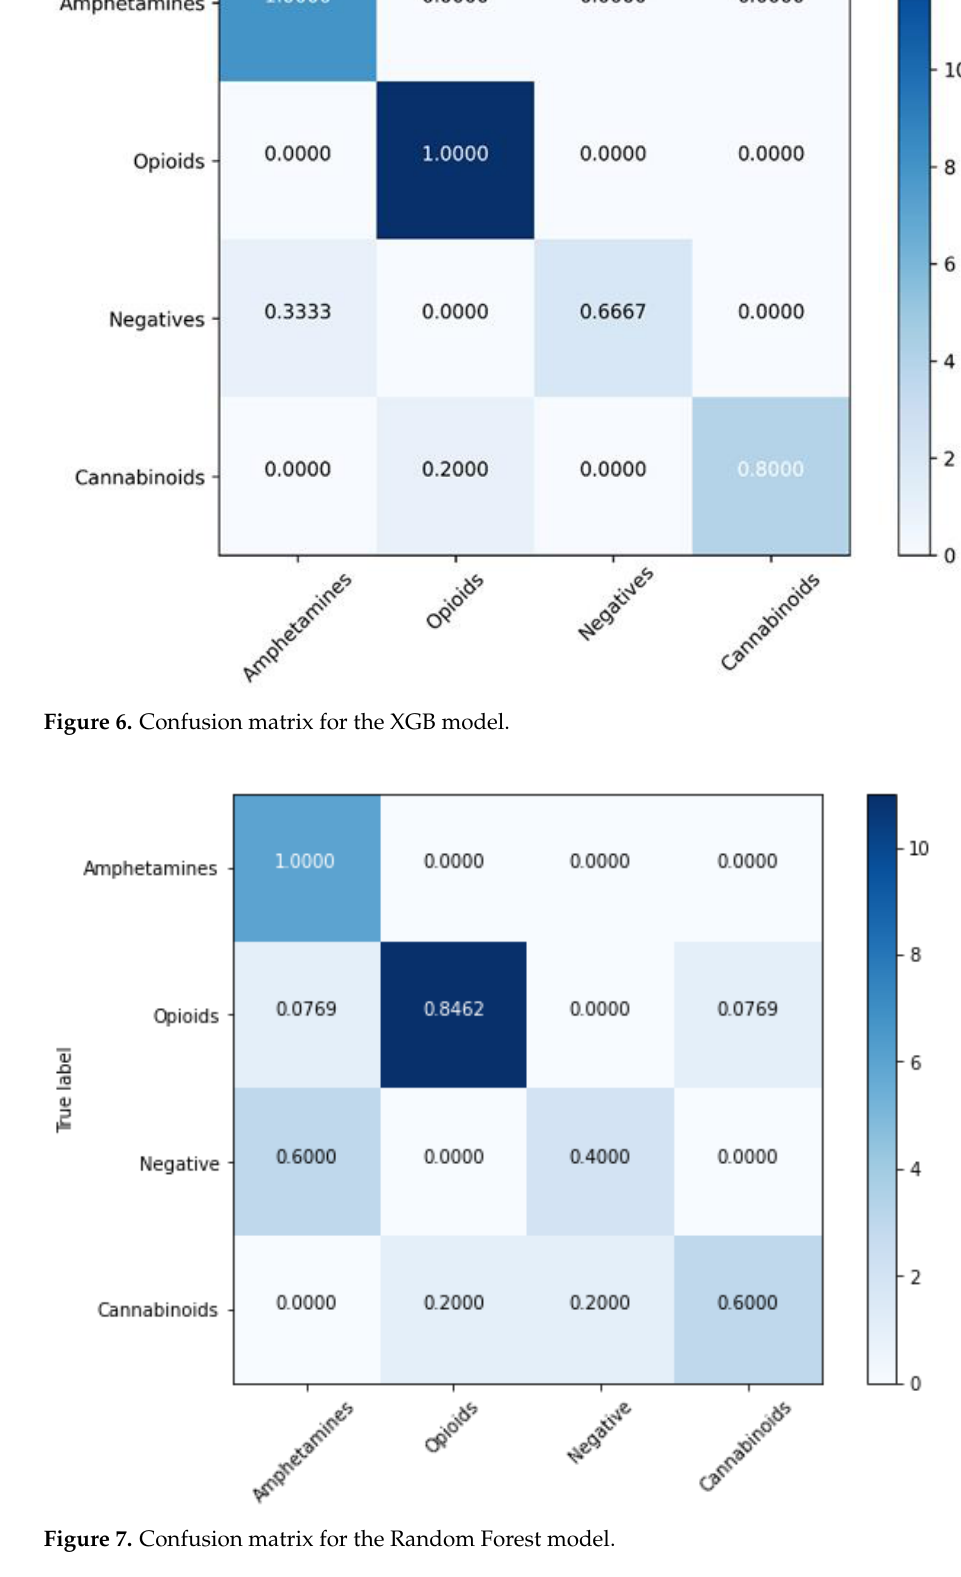
Figure 8. Confusion matrix for the Gradient Boosting model.